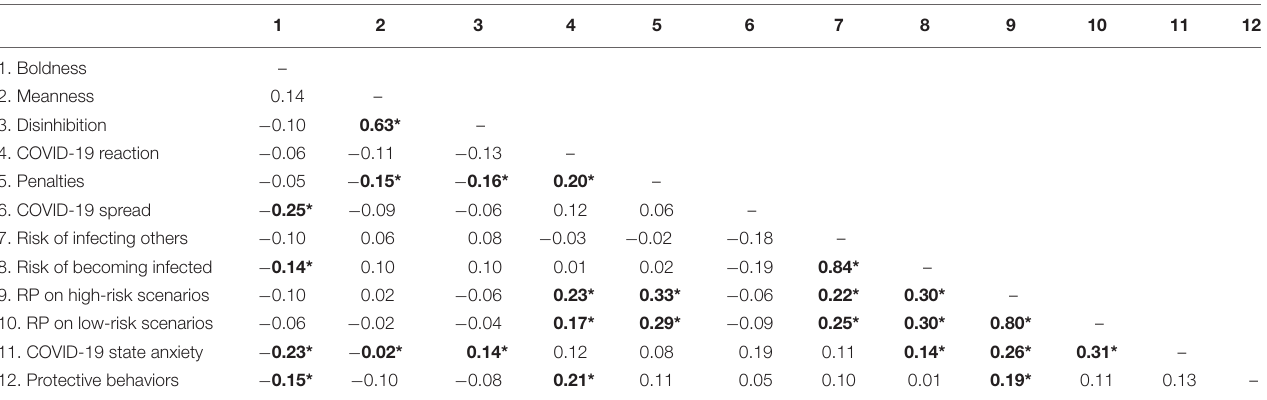
TABLE 1 | Pearson correlation coefficients for age, psychopathic traits, risk perceptions and behaviors related to the